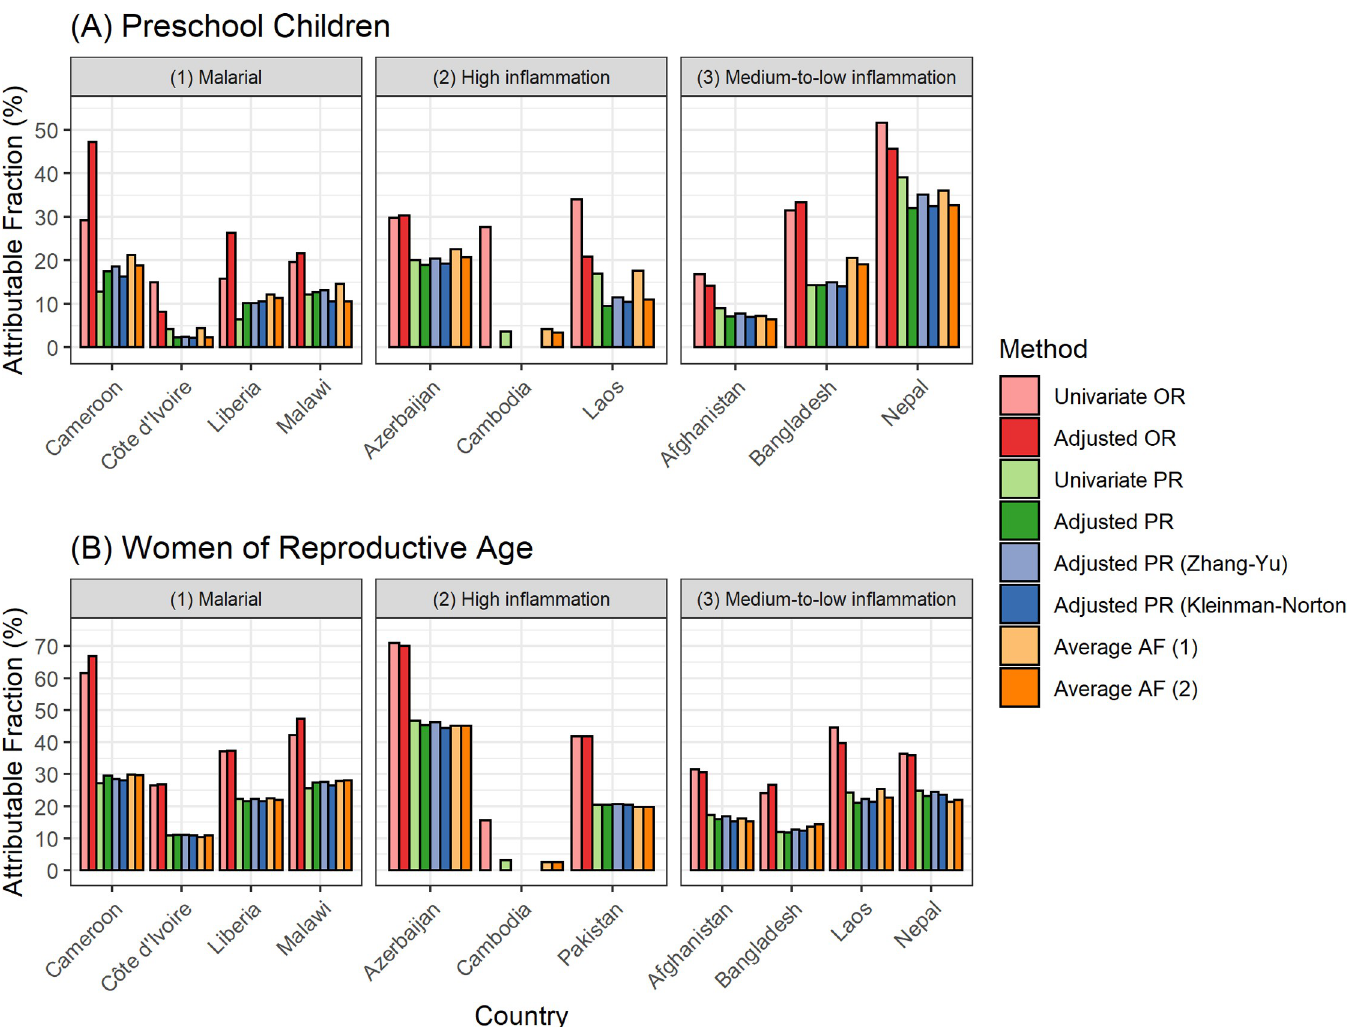
Fig 1. Estimated attributable fractions of anemia associated with iron deficiency in (A) preschool children and (B) women of reproductive age. Anemia defined as hemoglobin adjusted for altitude < 11.0 g/dL for children and hemoglobin adjusted for altitude and smoking < 12.0 g/dL for women. Inflammation-adjusted (using BRINDA regression adjustment method) ferritin concentrations < 12 μ g/L and < 15 μ g/L were used to define iron deficiency (ID) in children and women, respectively. Average AF (attributable fractions) (1) considers all exposure variables including inflammation, malaria, blood disorder, and other micronutrient deficiencies depending on data availability. Average AF (2) considers all exposure variables as above and further adjusts for age, sex (for children), and SES. Covariates for adjusted OR and adjusted PR included all available exposure variables, age, sex (for children), and SES. Adjusted AF were not available in Cambodia due to low prevalence of iron